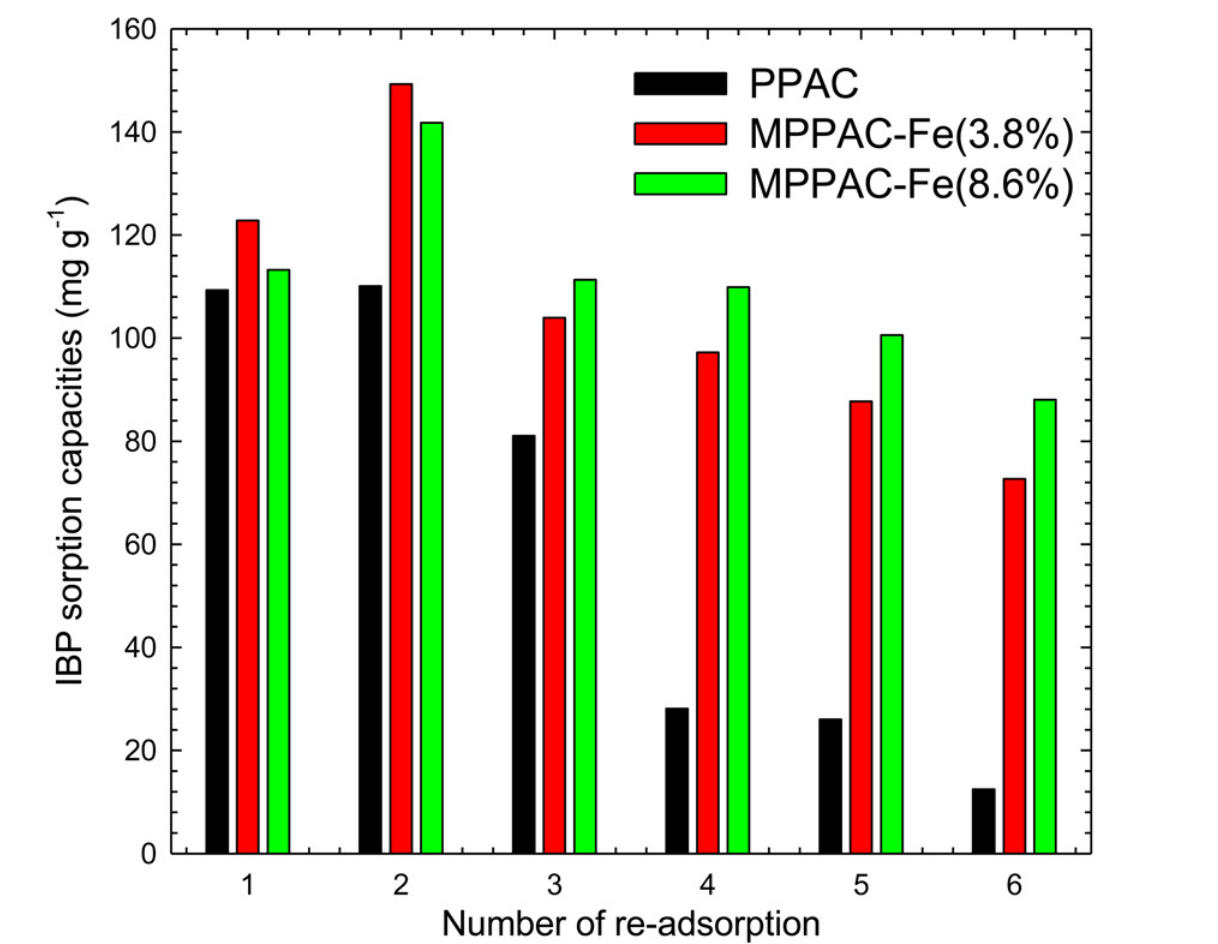
Fig 8. Adsorption capacities of saturated adsorbents after 6 cycles of thermal regeneration at 623.15 K.